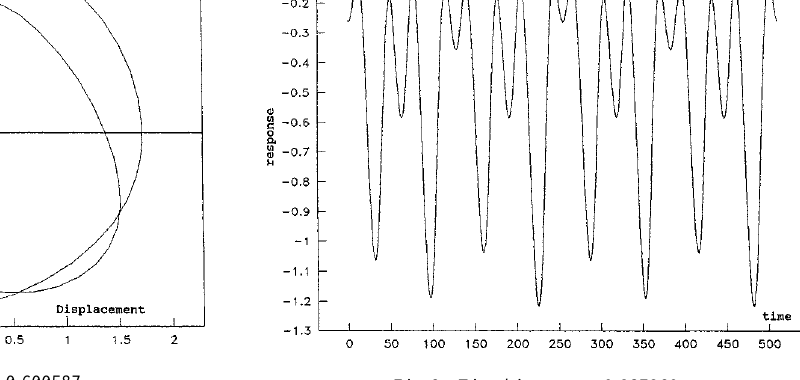
Fig. 6c. Time history q = 0 : 287360.